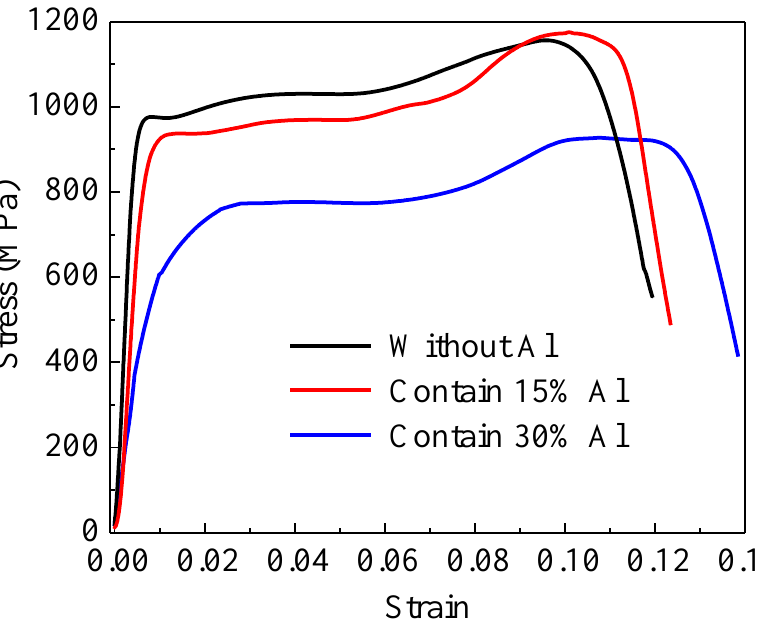
Figure 3. Dynamic compressive stress–strain curves of Ti–Al3Ti–Al laminated composites with different Al contents.